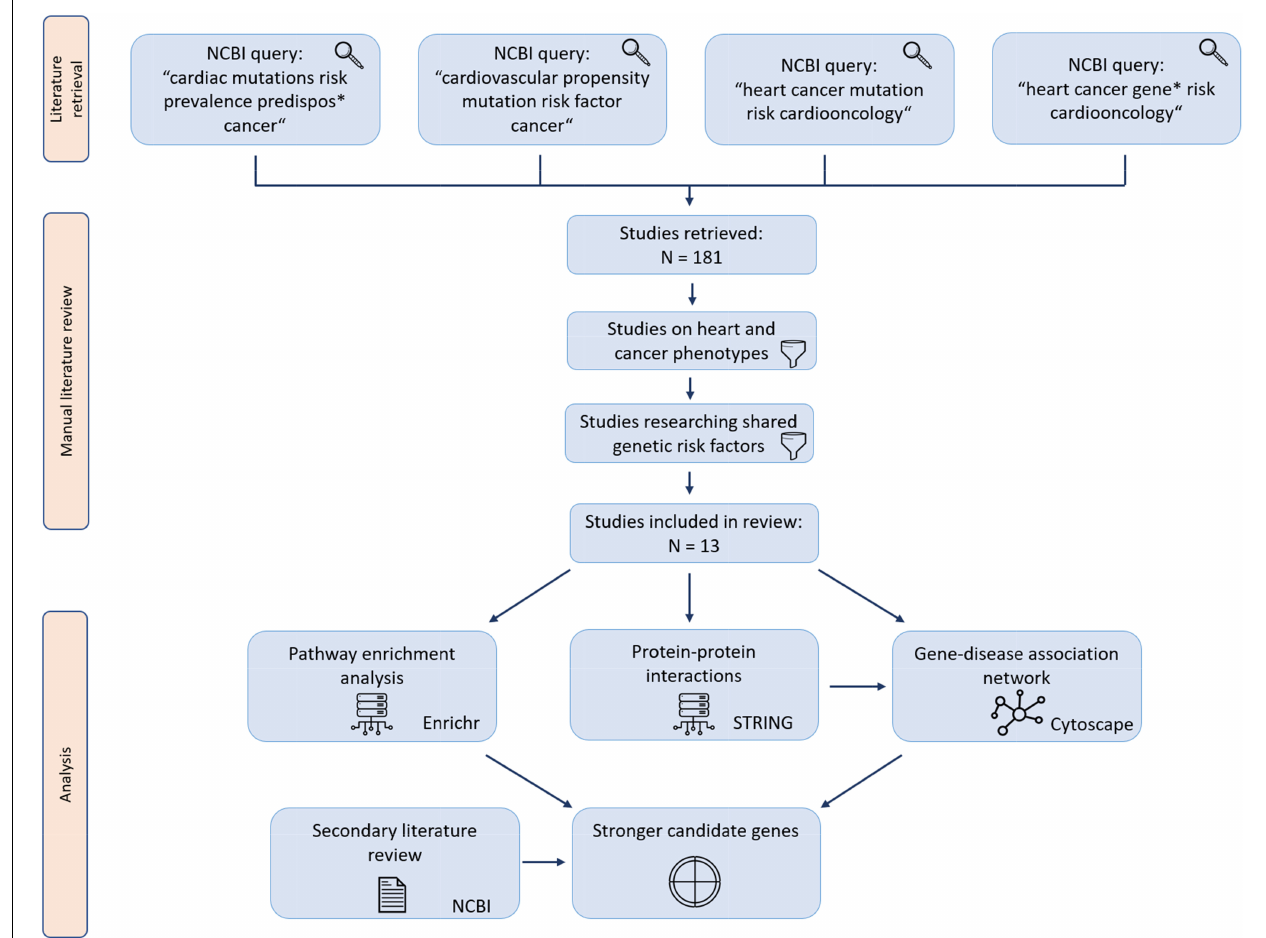
FIGURE 1 | Study workflow diagram. Retrieved studies were manually reviewed for studies matching the screening criteria.